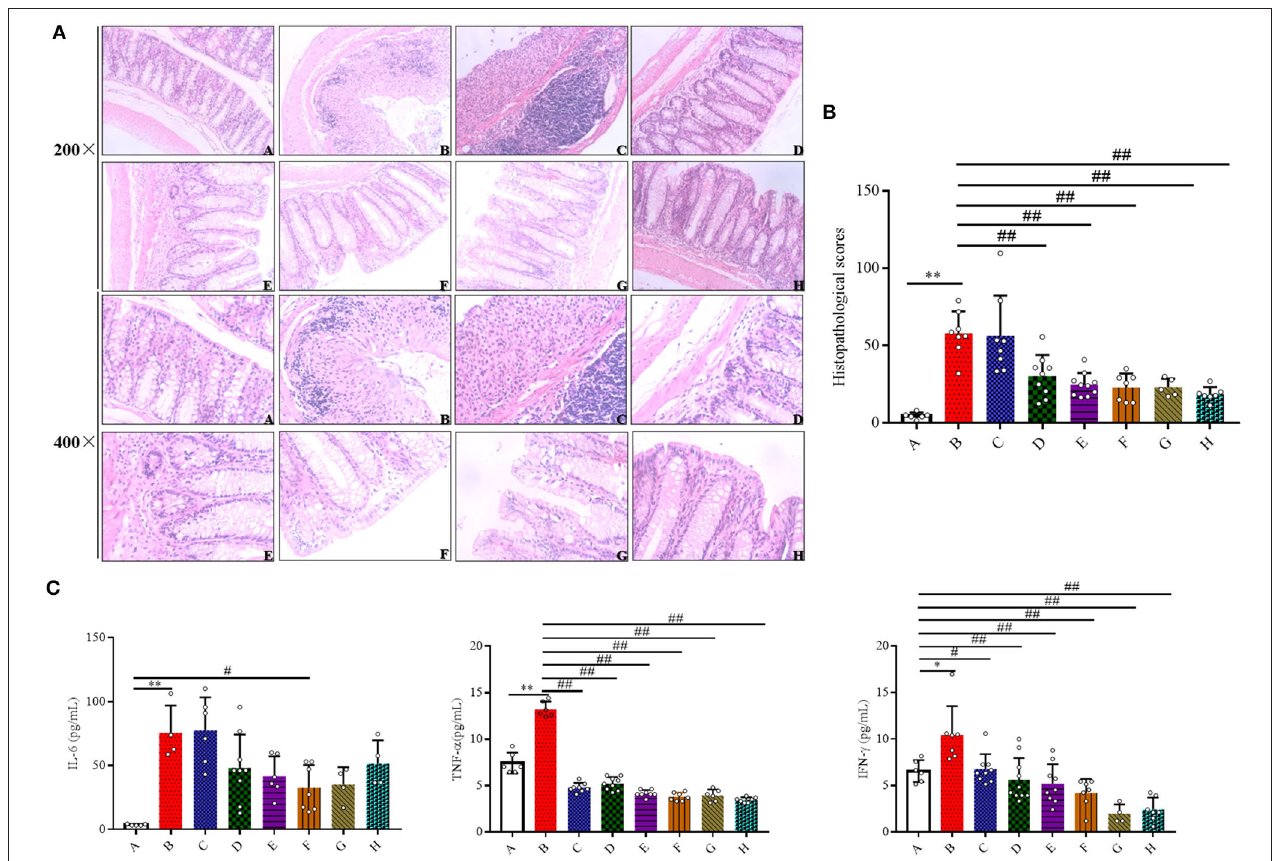
FIGURE 2 | Effects of SFN on histopathological characteristics and inflammatory in colitis mice. (A) Representative H&E staining of colon tissues (magnification × 200, and × 400). (B) Colonic histological score. (C) Effects of SFN on the concentrations of IL-6, TNF- α , and IFN- γ in plasma were determined by ELISA at a concentration of pg/ml. All data are presented as the mean ± SD. P- value < 0.05 was considered to indicate statistical significance (* P < 0.05 and ** P < 0.01 compared with Group A, # P < 0.05 and ## P < 0.01 compared with Group